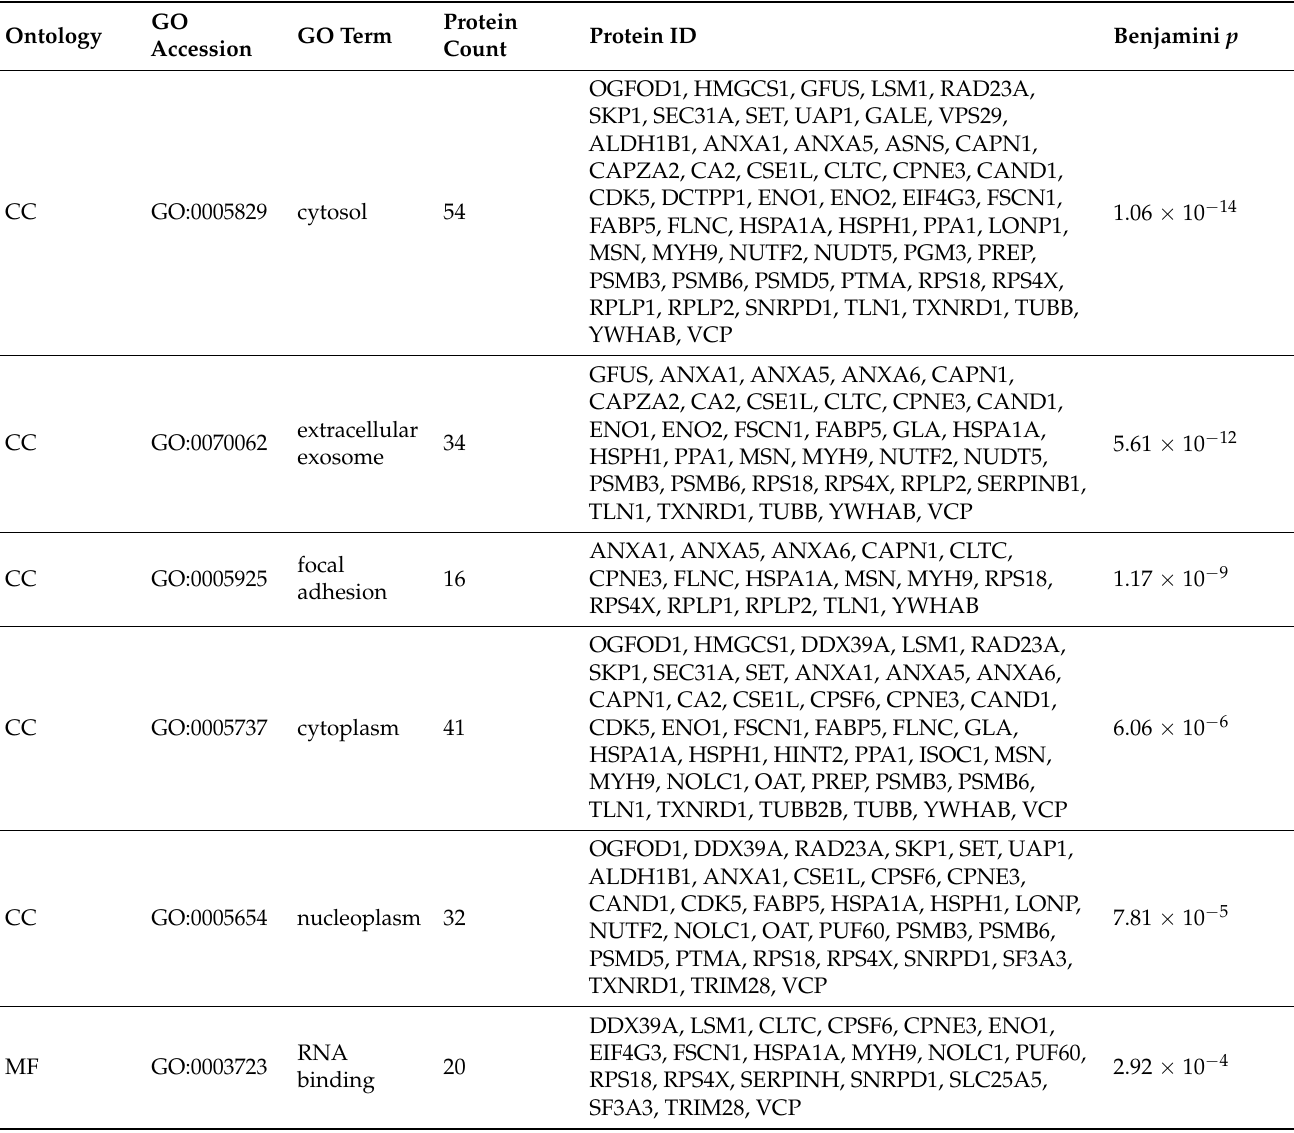
Table 2. Summary of GO enrichment analysis in ARC-KO-related differentially expressed